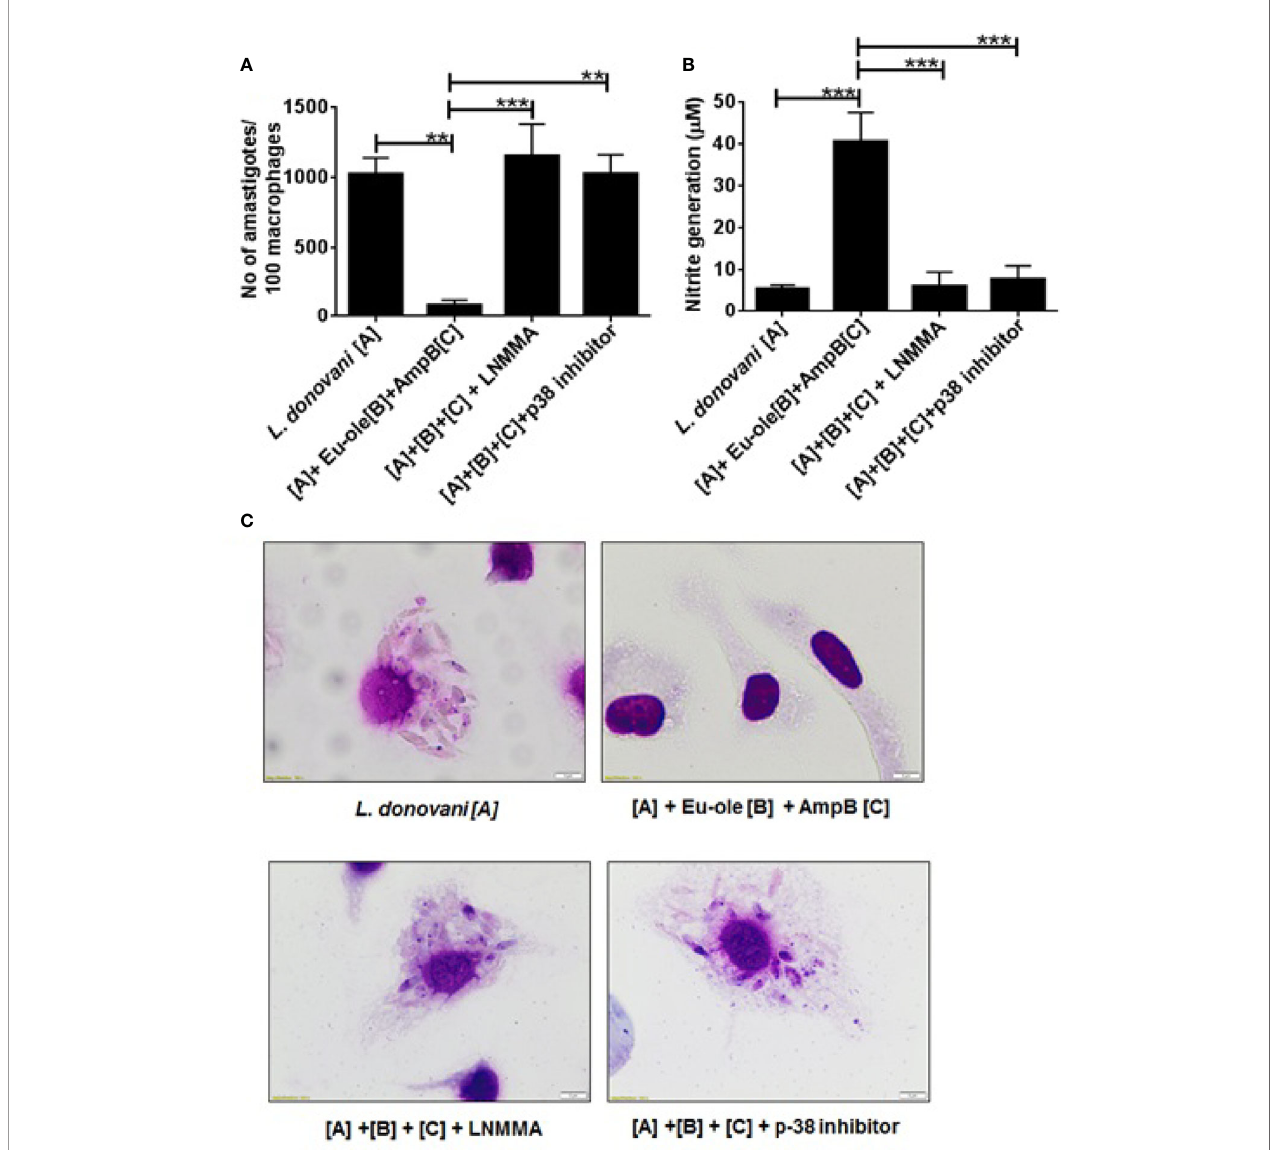
FIGURE 5 | Effect of combination therapy in anti-leishmanial activity and NO generation in presence of inhibitors. Cells were pre-treated with p38 inhibitor (SB203580 at 5 m g/ml), iNOS inhibitor ( L -NMMA at 0.4 mM) for 1 h followed by combination treatment. After 48 h of post treatment anti-amastigote study was performed by Giemsa staining method and NO generation was performed by Griess assay. (A) showed parasites per 100 macrophages, (B) showed NO generation in presence of inhibitor and (C) showed the representative macrophage images. **p < 0.01, ***p < 0.001, signi fi cant differences between the indicated